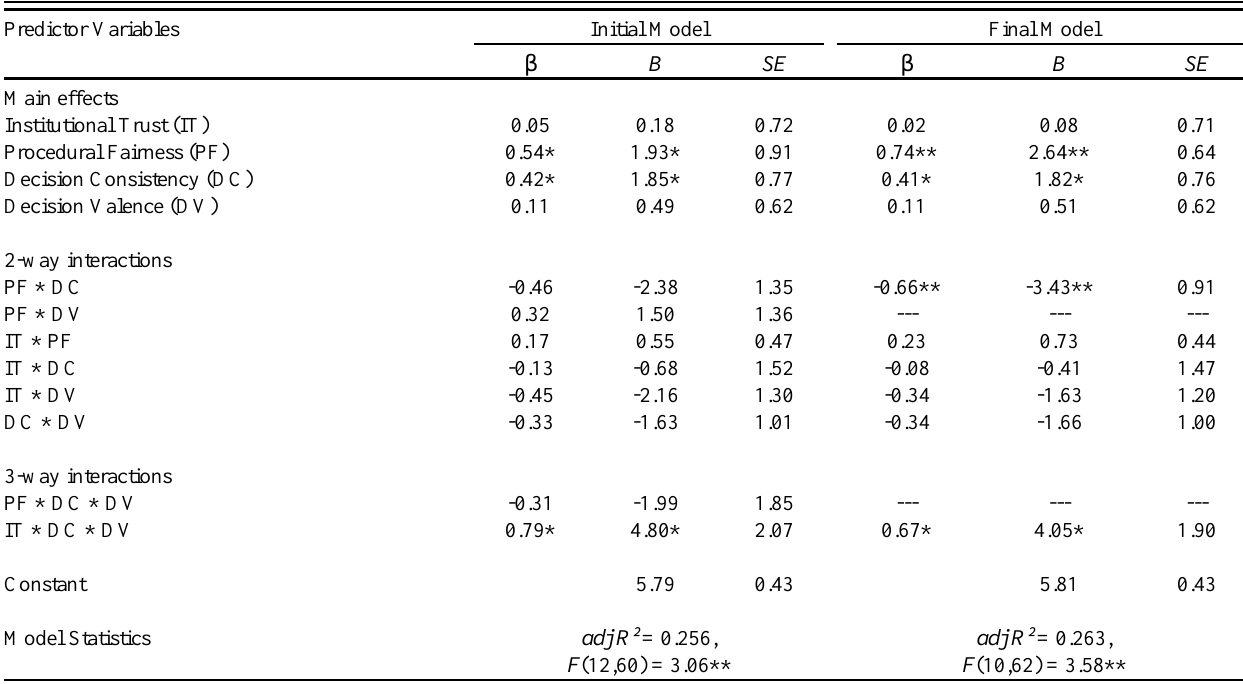
Table 3 . Final compliance regression